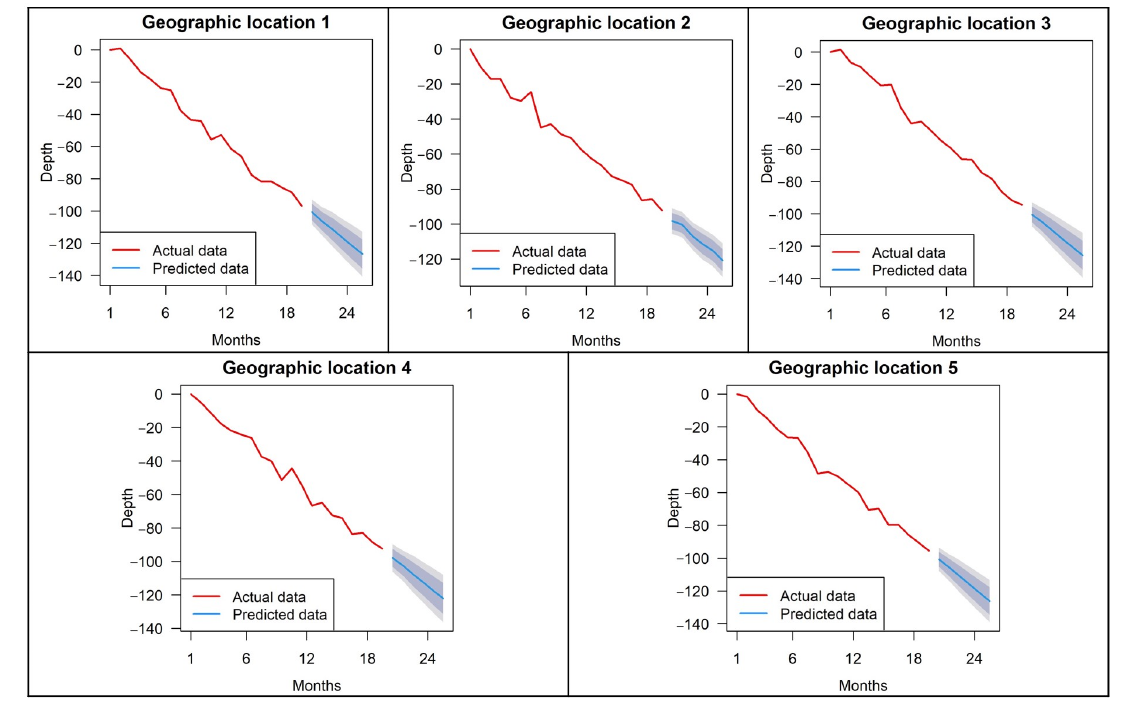
Figure 16. ARIMA model prediction results (Unit: mm). Table 3. Comparison of predictive model performance